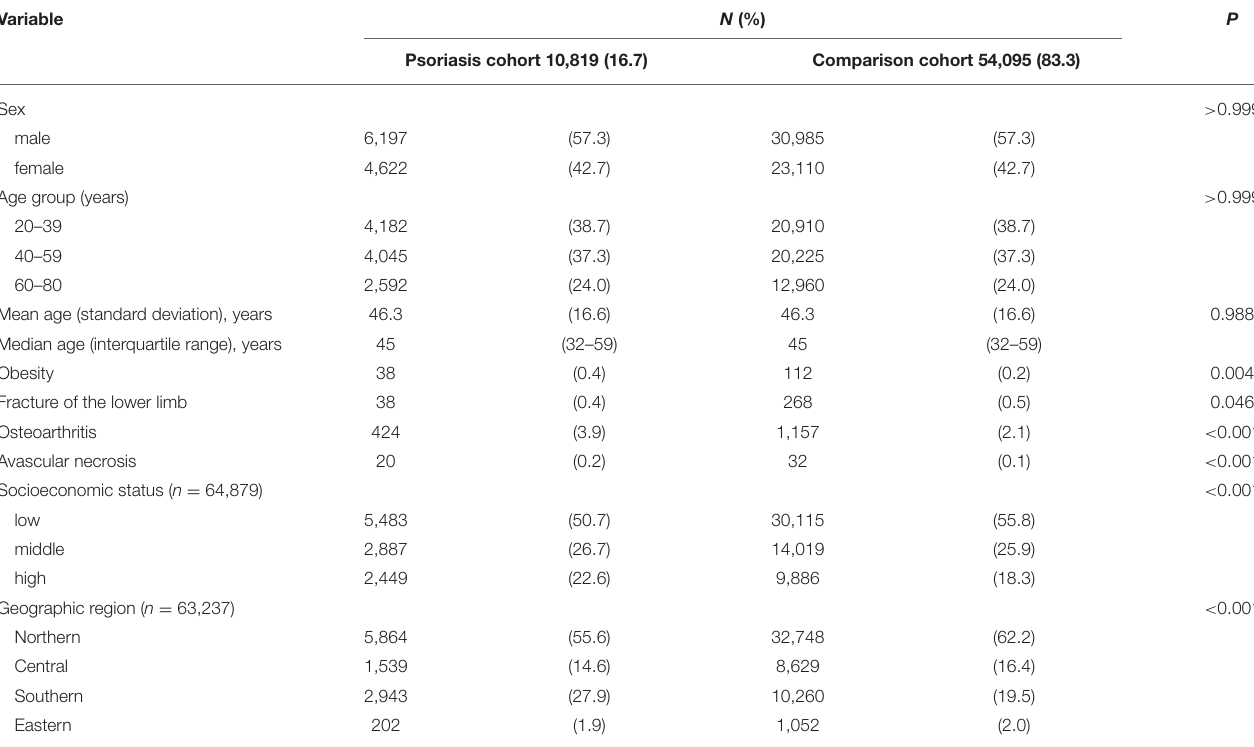
TABLE 1 | Basic characteristics of the psoriasis cohort and comparison cohort ( N = 64,914). Variable